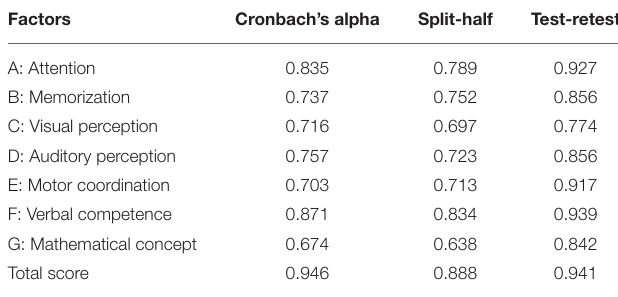
TABLE 3 | The reliability of the preschool learning skills scale ( n =